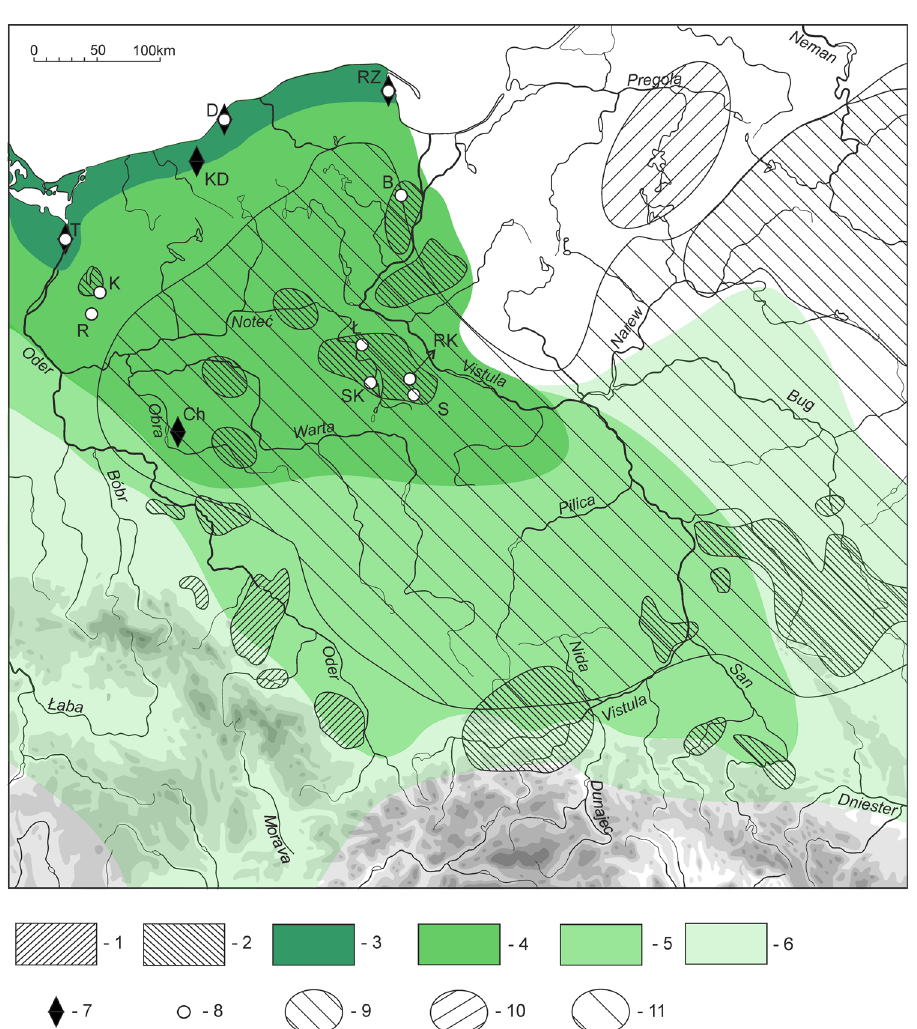
Figure 6: Spread of the TRB in the north - eastern part of Central Europe in the context of the late post - LBK ( late Lengyel - Polgár complex ) and para - Neolithic groups ( based on Koz ł owski & Nowak, 2019, Figure 51, with modi fi cations ) . ( 1 and 2 ) Main territories of the late Lengyel - Polgár complex settlement ( 1 – the Lengyel complex sensu largo, mainly the Jordanów culture, 2 – groups with “ Polgár ” features ) ; ( 3 ) the area of formation of the TRB c. 4200 – 4000 BC ( “ the Middle Ground ” ? ) ; ( 3 and 4 ) range of the TRB c. 4000 – 3900 BC; ( 3 – 5 ) range of the TRB, c. 3800/3700 BC; ( 3 – 6 ) range of the TRB after 3700/3600 BC; ( 7 ) sites with the Ertebølle and Ertebølle - like pottery ( T – Tanowo 3, D – D ą bki 9, KD – Koszalin - Dzier żę cino, RZ – Rzucewo, Ch – Chobienice ) ; ( 8 ) selected sites with the early TRB pottery ( T – Tanowo 3, K – Kosin 6, R – Renice 5 – 6, D – D ą bki 9, RZ – Rzucewo, B – Bielawki 5, Ł – Łą cko 6, SK – Strzelce Krzy ż anna 56, RK – Redecz Krukowy, S – Sarnowo 1 ) ; ( 9 ) range of the Neman culture in the late fi fth millennium BC; ( 10 ) range of the Zedmar culture; ( 9 and 11 ) range of the Neman culture in the fourth and third millennia